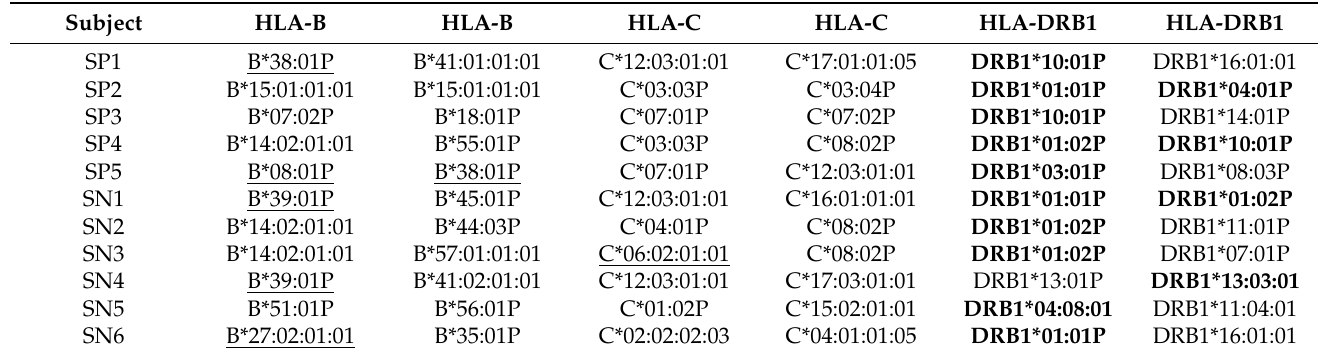
Table 2. HLA typing for the genes HLA-B, HLA-C and HLA-DRB1. The table displays the HLA-B, HLA-C and HLA-DRB1 alleles carried by each patient. Alleles associated with RA development are reported in bold, while PsA/psoriasis risk alleles are